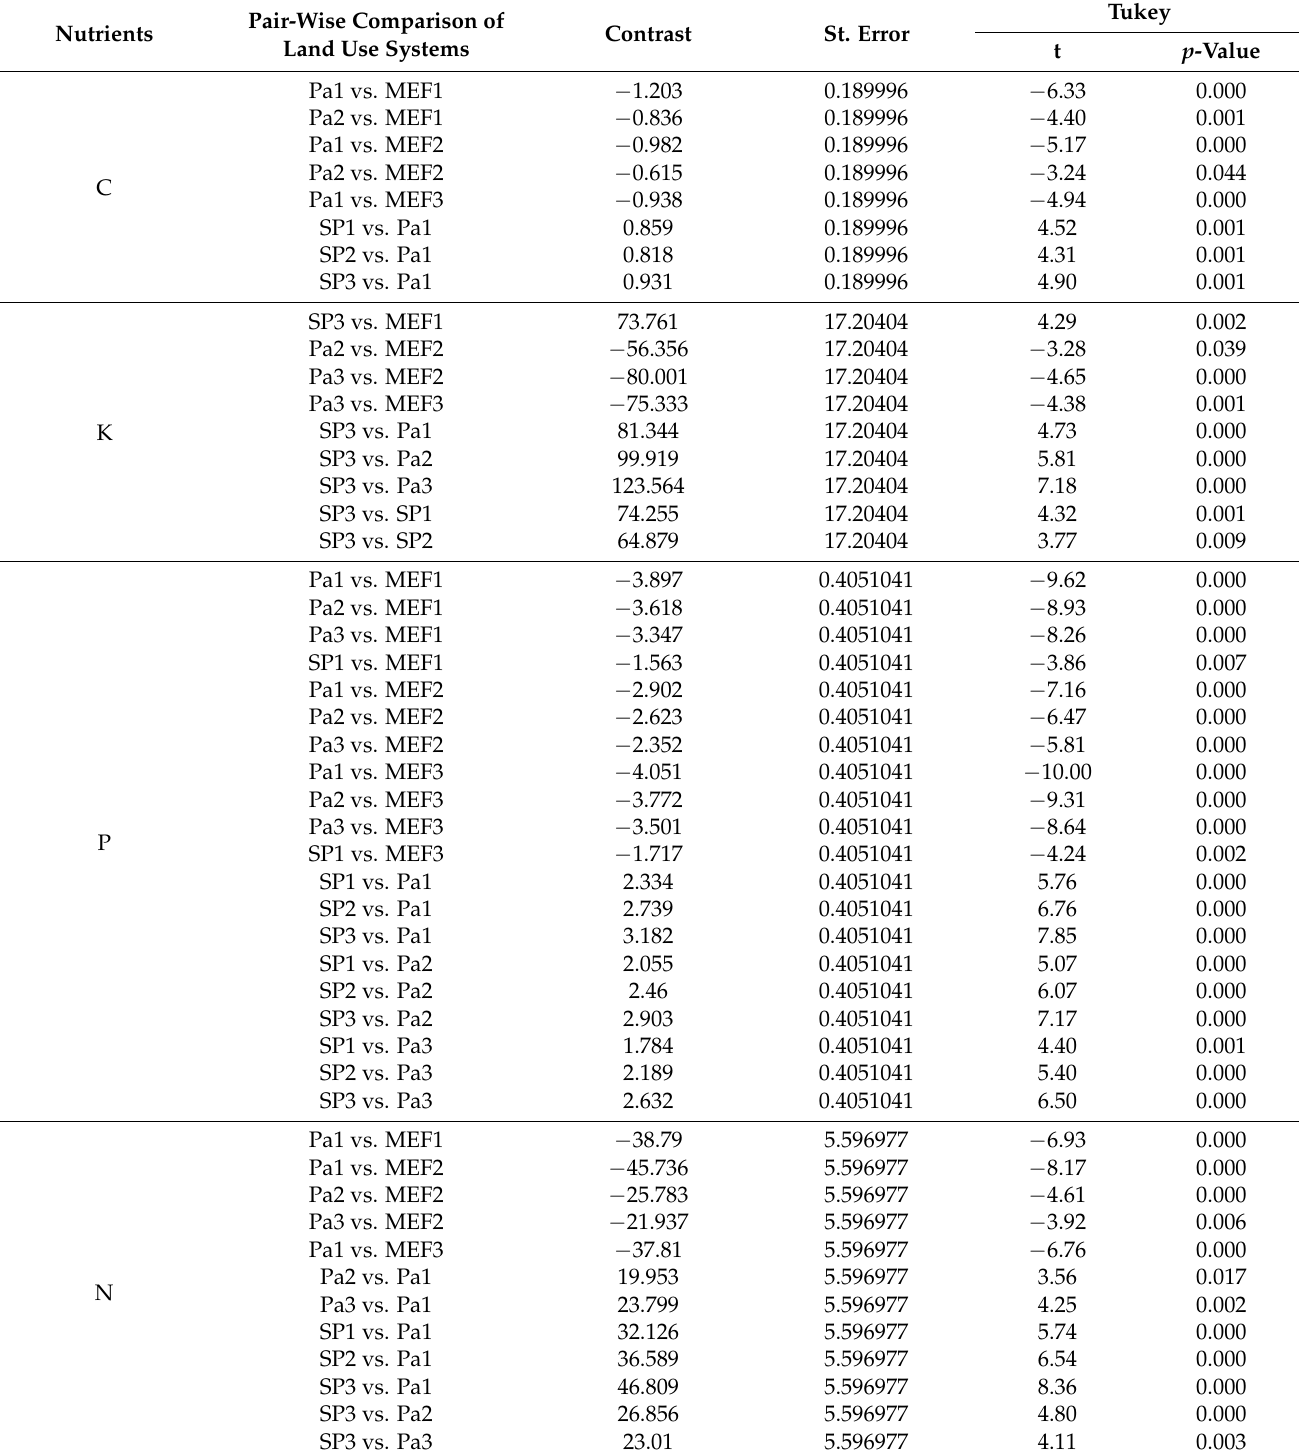
Table 6. Land use post hoc analysis results of soil nutrients (C, K, P, and N).